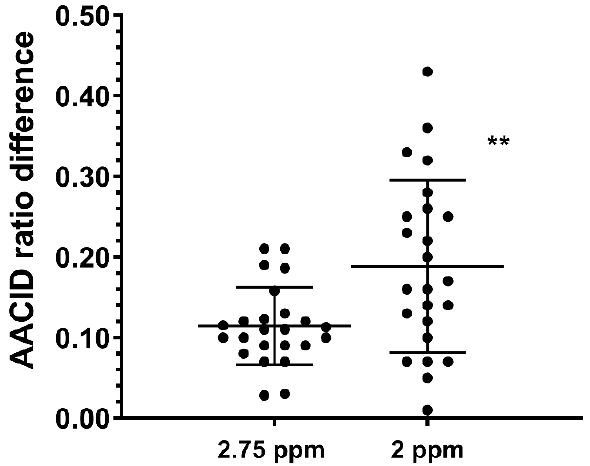
Figure 3. Average difference in AACID values between U87MG tumors and contralateral tissue in 24 mice when using the 2.75 ppm and 2.0 ppm amine resonances. ** indicates p < 0.001 in a repeated measures two-tailed t-test. Error bars represent the standard error of the mean.